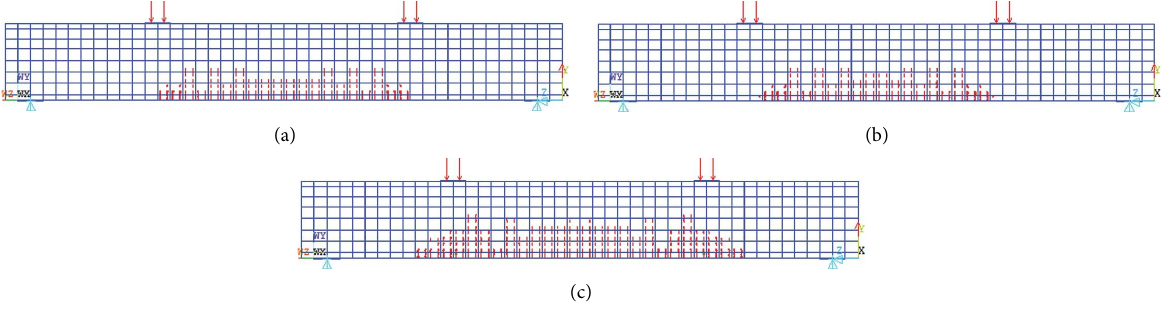
� 8 kN), μ � 0; (b) cracks begin to appear in crack